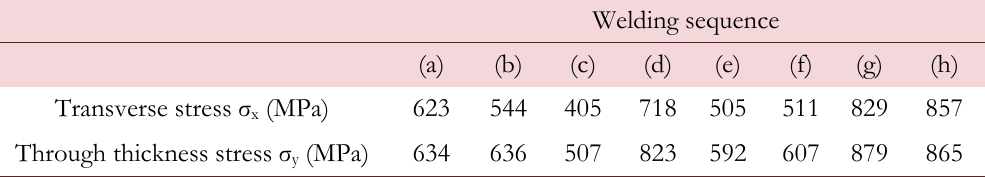
Table 1: Predicted residual stress peak values for different cases of welding sequences